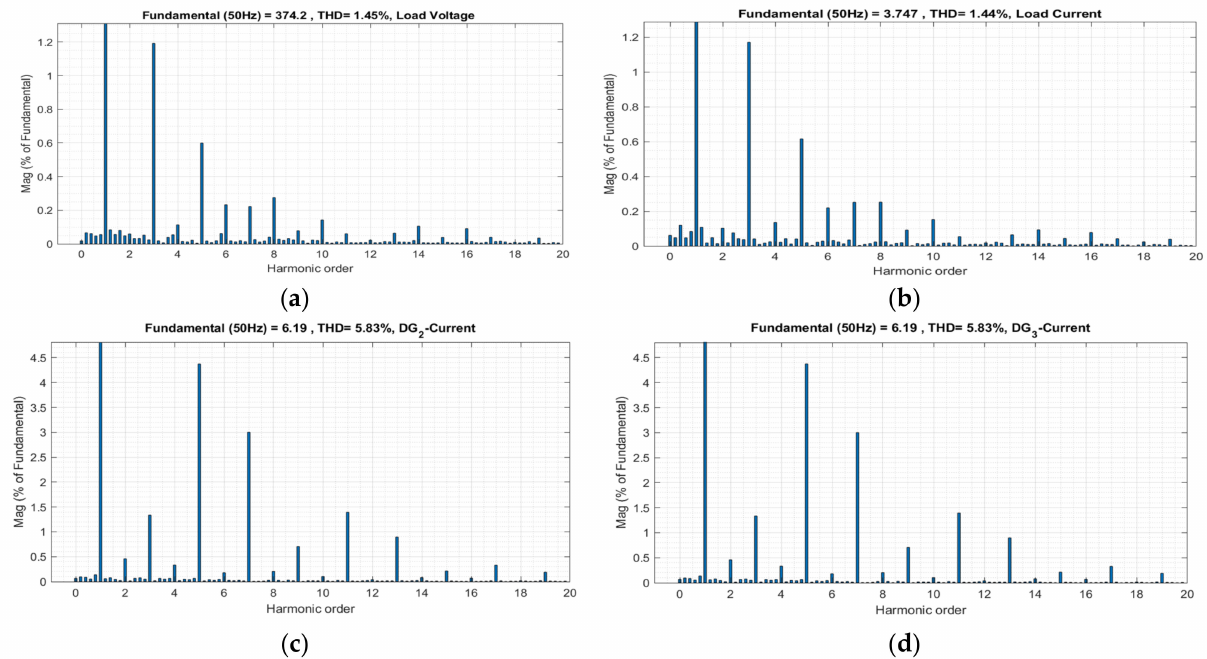
Figure 8. Load Voltage and Current THD Analyzing Under Nonlinear Load: ( a ) the THD of the Load Voltage, ( b ) the THD of the Current Load, ( c ) the THD of the DG2, ( d ) the THD of the DG3.